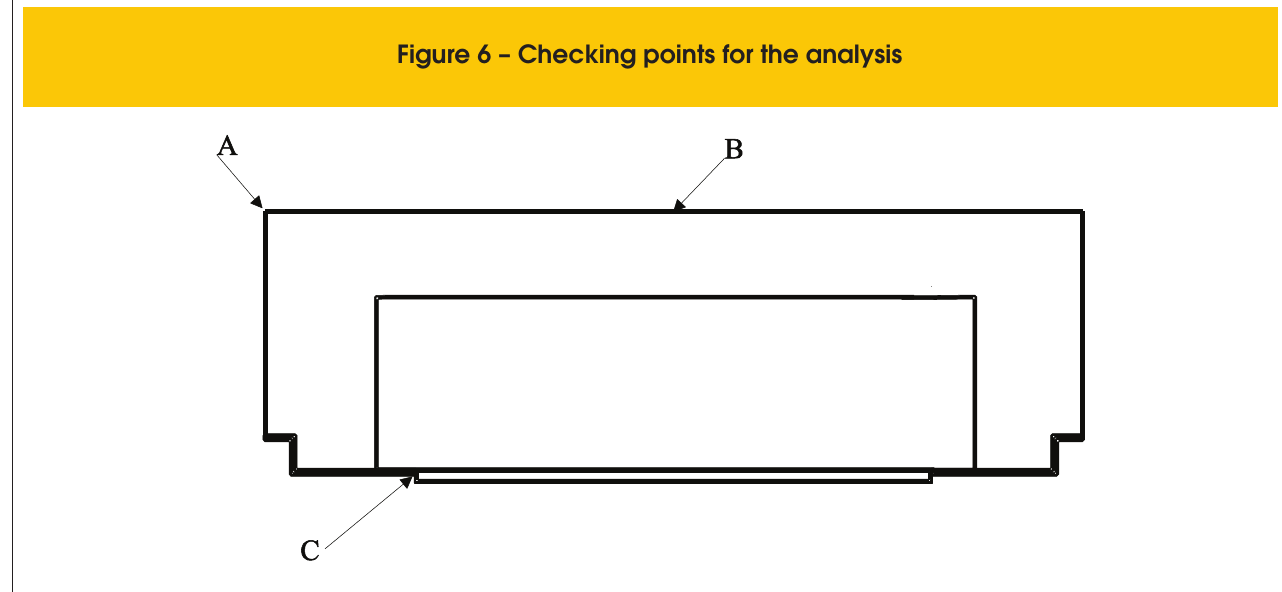
Figure 6 – Checking points for the